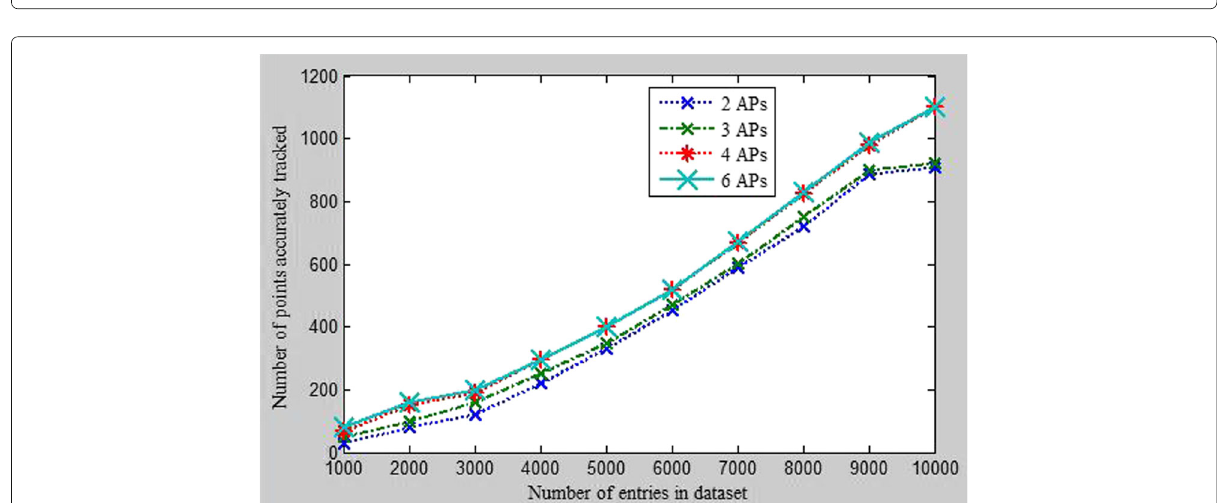
Fig. 6 Graph for RMSE v/s Number of tuples in dataset